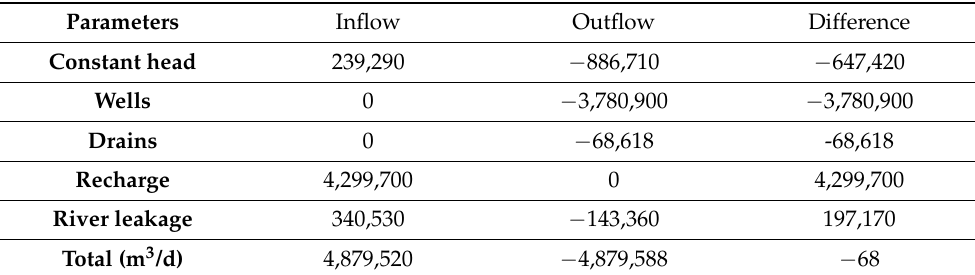
Table 2. The Total Inflow and Outflow